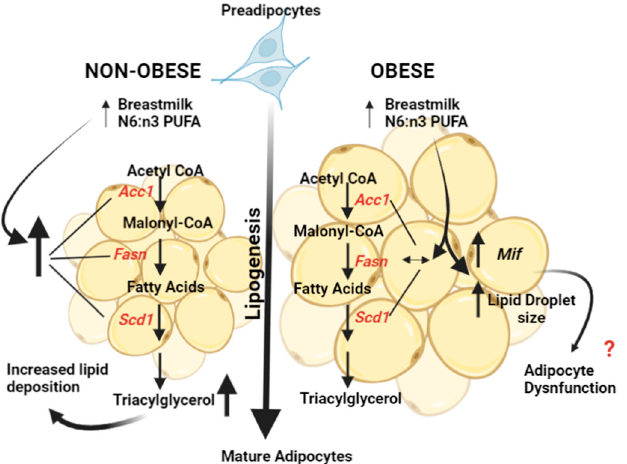
Figure 4. Proposed mechanisms by which breast milk composition affects adipocyte function. Breast milk (BM) of non-obese women with a high omega (n)-6:n-3 PUFA ratio increased the mRNA expression of lipogenic genes, whereas BM of women with obesity resulted in a larger lipid droplet size, suggesting adipocyte dysfunction. Acc1 —acetyl CoA carboxylase; Fasn —fatty acid synthase; Mif —macrophage migration inhibitory factor; Scd1 —stearoyl-CoA desaturase-1. Supplementary Materials: The following supporting information can be downloaded at: www.mdpi.com/xxx/s1, Figure S1: CONSORT flow diagram for participant selection; Figure S2: Effects of breast milk from women with obesity on the mRNA expression of macrophage migration inhibitory factor ( Mif ); Figure S3: The effect of maternal obesity on malondialdehyde (MDA) levels in breast milk; Table S1: Primer sequences for qPCR; Table S2: The fatty acid composition of breast milk by quartiles with low and high n-6:n-3 PUFA ratios.